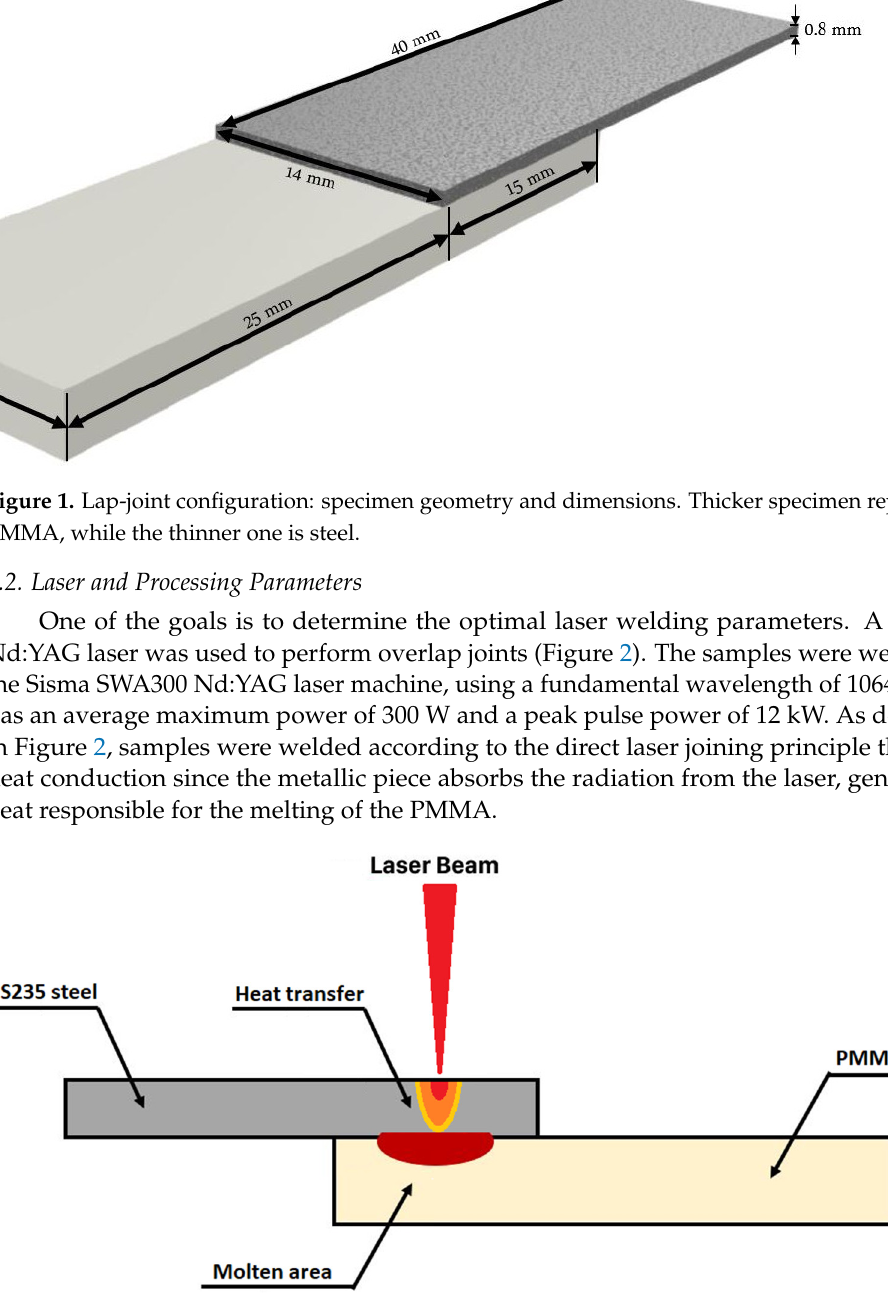
Figure 2. Schematics of the laser direct joining technique through heat conduction.